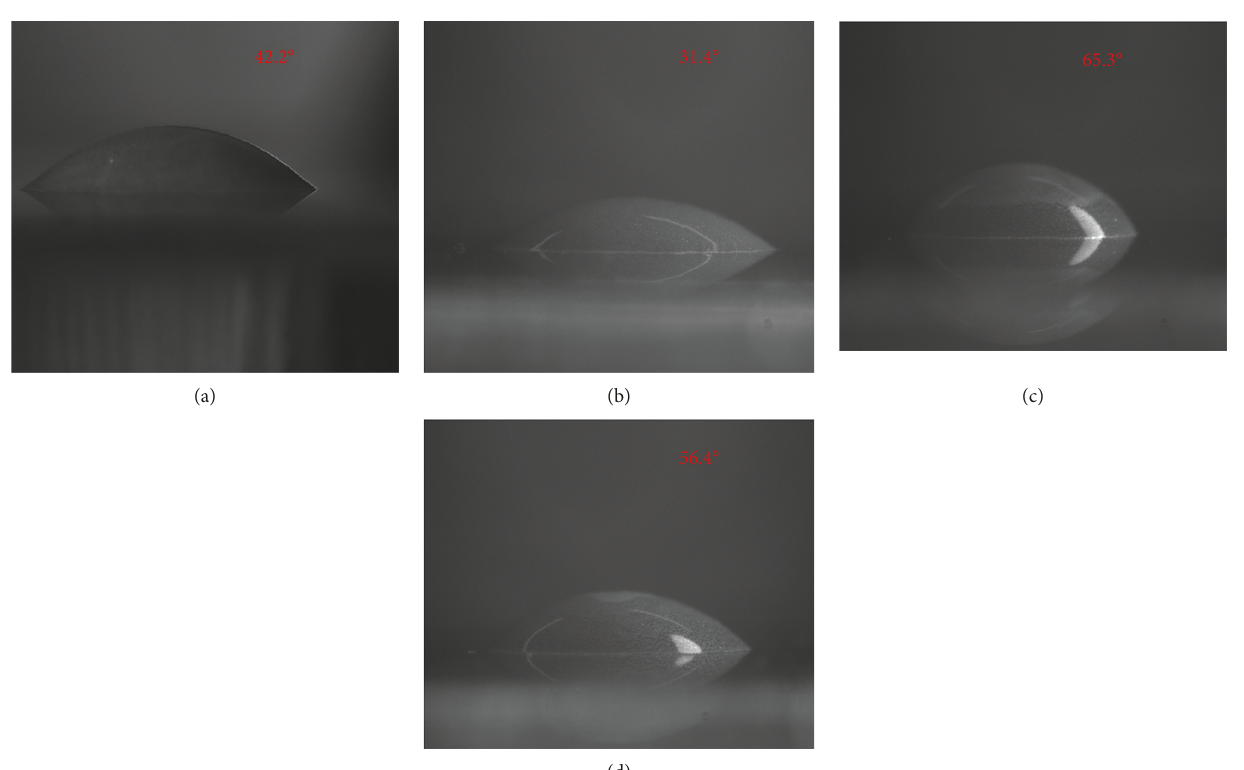
Figure 17: contact angle measurement diagram. (a) Without modification. (b) 3082 modified solution. (c) 310 modified solution. (d) Glaco modified